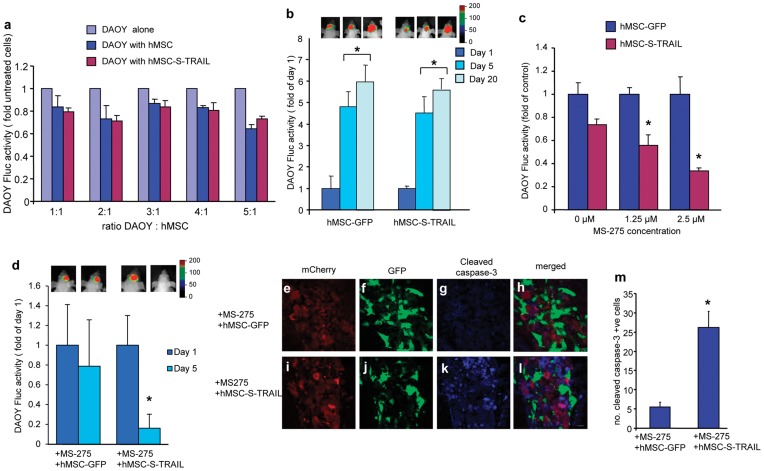
MS-275 treatment sensitizes TRAIL resistant DAOY cells to hMSC-S-TRAIL in vivo.(a) Plot showing the viability of DAOY-Fluc-mCherry MB cells co-cultured with hMSC-GFP or hMSC-S-TRAIL with different ratios of MB to hMSC cells. (b) Fluc bioluminescence intensities of intraparenchymally implanted mice with DAOY-Fluc-mCherry human MB cells mixed with either hMSC-GFP or hMSC-S-TRAIL on Days 1, 5 and 20. Representative images of mice for each group are shown. (c) Plot showing the viability of DAOY-Fluc-mCherry MB cells pre-treated with increasing concentrations of MS-275 and incubated with hMSC-GFP or hMSC-S-TRAIL. (d) Fluc bioluminescence intensities of intraparenchymally implanted mice with MS-275 treated DAOY-Fluc-mCherry human MB cells mixed with either hMSC-GFP or hMSC-S-TRAIL on Days 1 and 5. Representative images of mice for each group are shown. (e–l) Photomicrographs and immunohistochemistry of brain sections from mice bearing DAOY tumors treated with MS-275 and with hMSC-GFP or hMSC-S-TRAIL: DAOY cells expressing mCherry (e,i); hMSC-GFP (f) and hMSC-S-TRAIL (j) cells expressing GFP; Cleaved caspase-3 staining (g,k). Merged image (h,l; Red, mCherry expression; green, GFP expression; blue, cleaved caspase-3 staining). (m) Plot shows the number of cleaved caspase-3-positive DAOY cells in MS-275-pretreated tumors with hMSC-GFP or hMSC-S-TRAIL. (Original magnification: e–l, ×20.). * denotes p<0.05 in the comparison of each treatment to controls, student’s t-test.